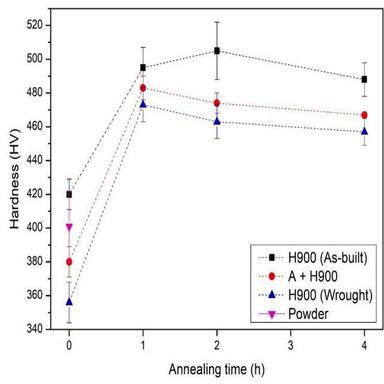
Hardening behavior in samples of different conditions. H900 stands for samples aged at 482 ◦C, for the different times shown. A stands for the Annealed condition (1040 ◦C/30 min).